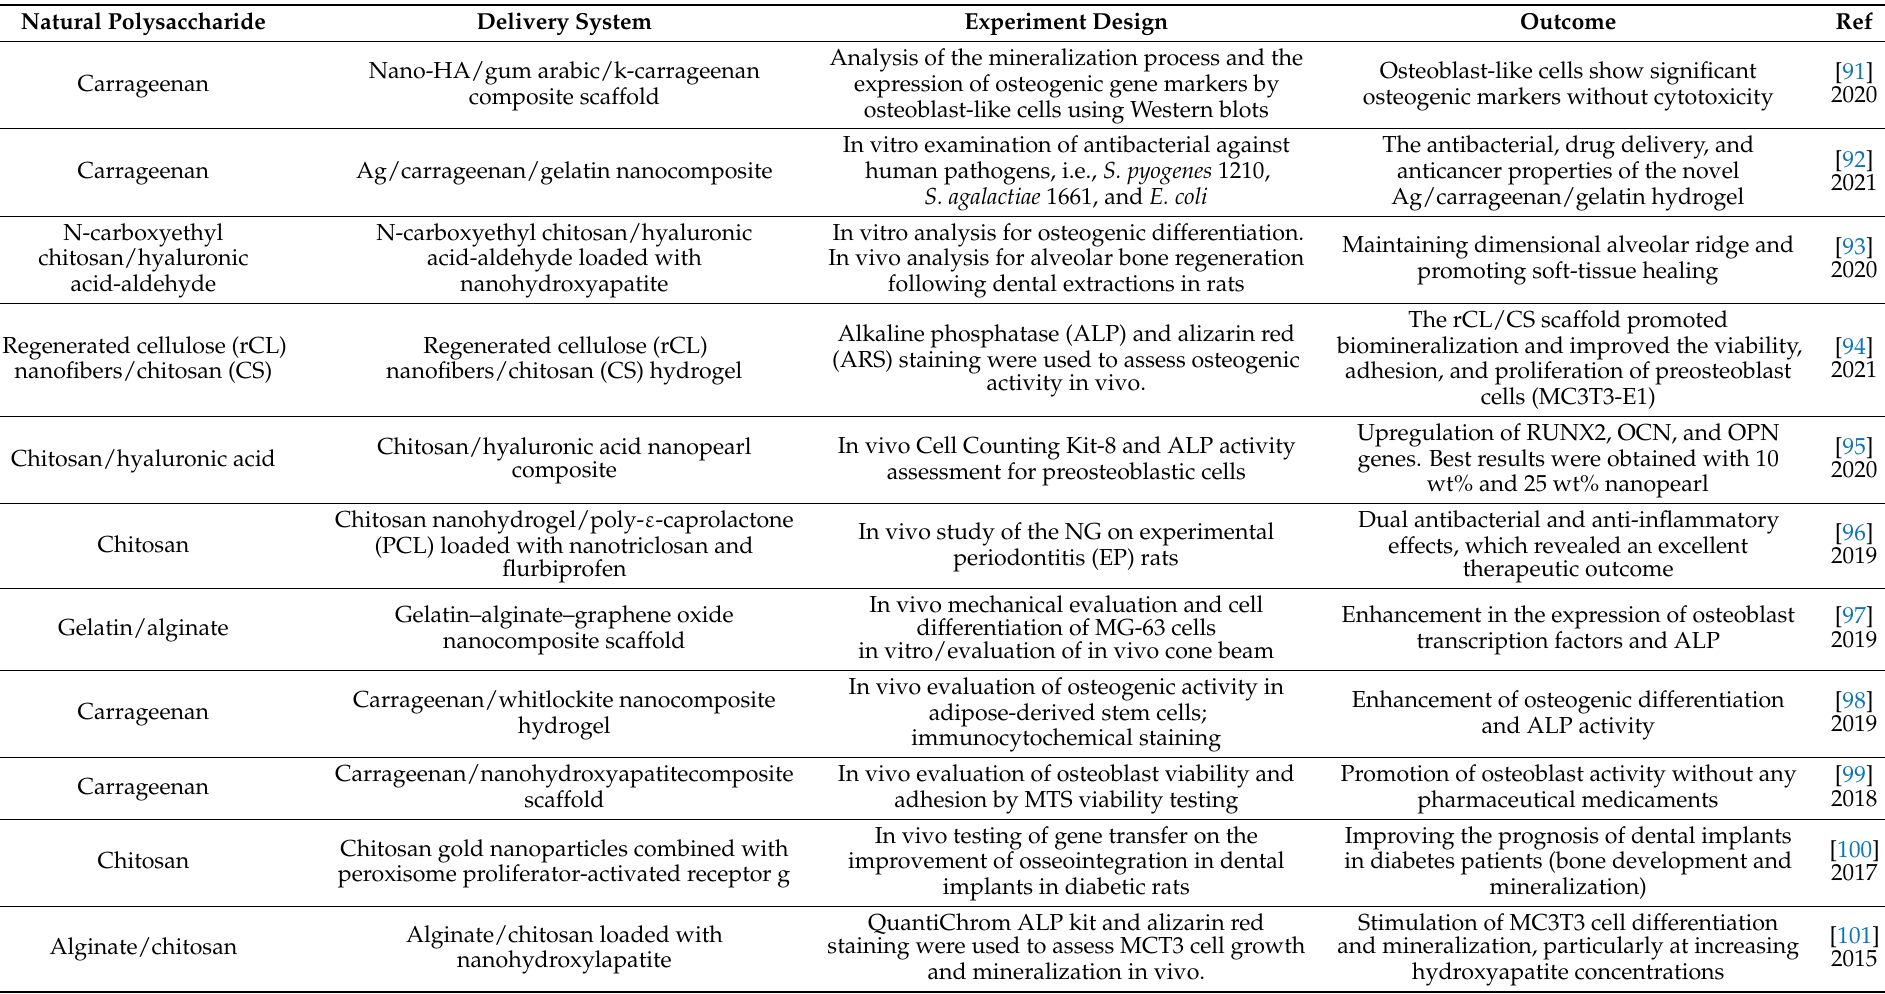
Table 4. Experiment design of natural polysaccharides loaded with different bioactive materials as